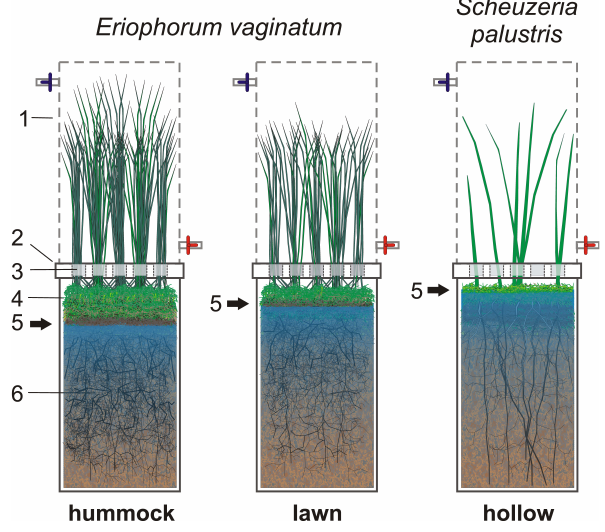
Fig. 1. Isolation of shoots from roots and entire peat cores in meso- cosms of E . vaginatum and S. palustris sampled at hummocks, lawns and hollows of a boreal natural minerogenic, oligotrophic fen Salmisuo in Eastern Finland. Microforms differed by water table level (12-5-0cm below surface for hummocks, lawns and hollows, respectively) maintained in the laboratory experiment. 1 – chambers used for gases flux measurements, 2 – lid with holes used for isola- tion of shoots from peat cores; 3 – holes in lids with passed through tillers sealed with silicone; 4 – green moss ( Sphagnum